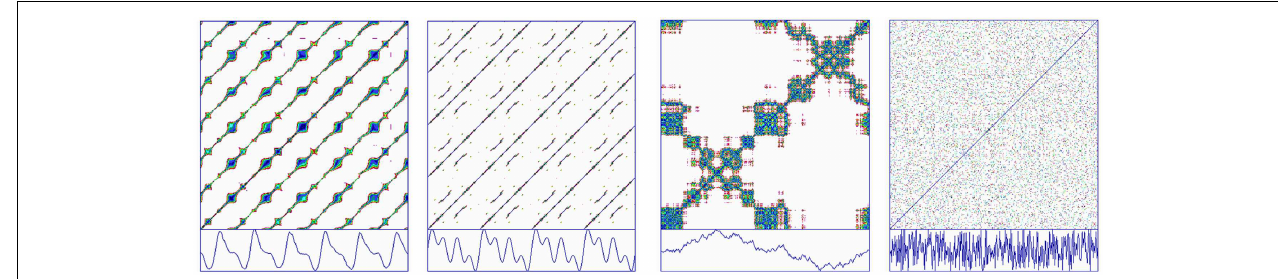
FIGURE 7 | Recurrence plots (top) of time series (bottom) including (left to right): tracheal pressure (rodent); pink noise (auto-regressive process of integrated white noise); Hénon chaotic attractor ( x variable); white noise (caesium 137 beta decay).